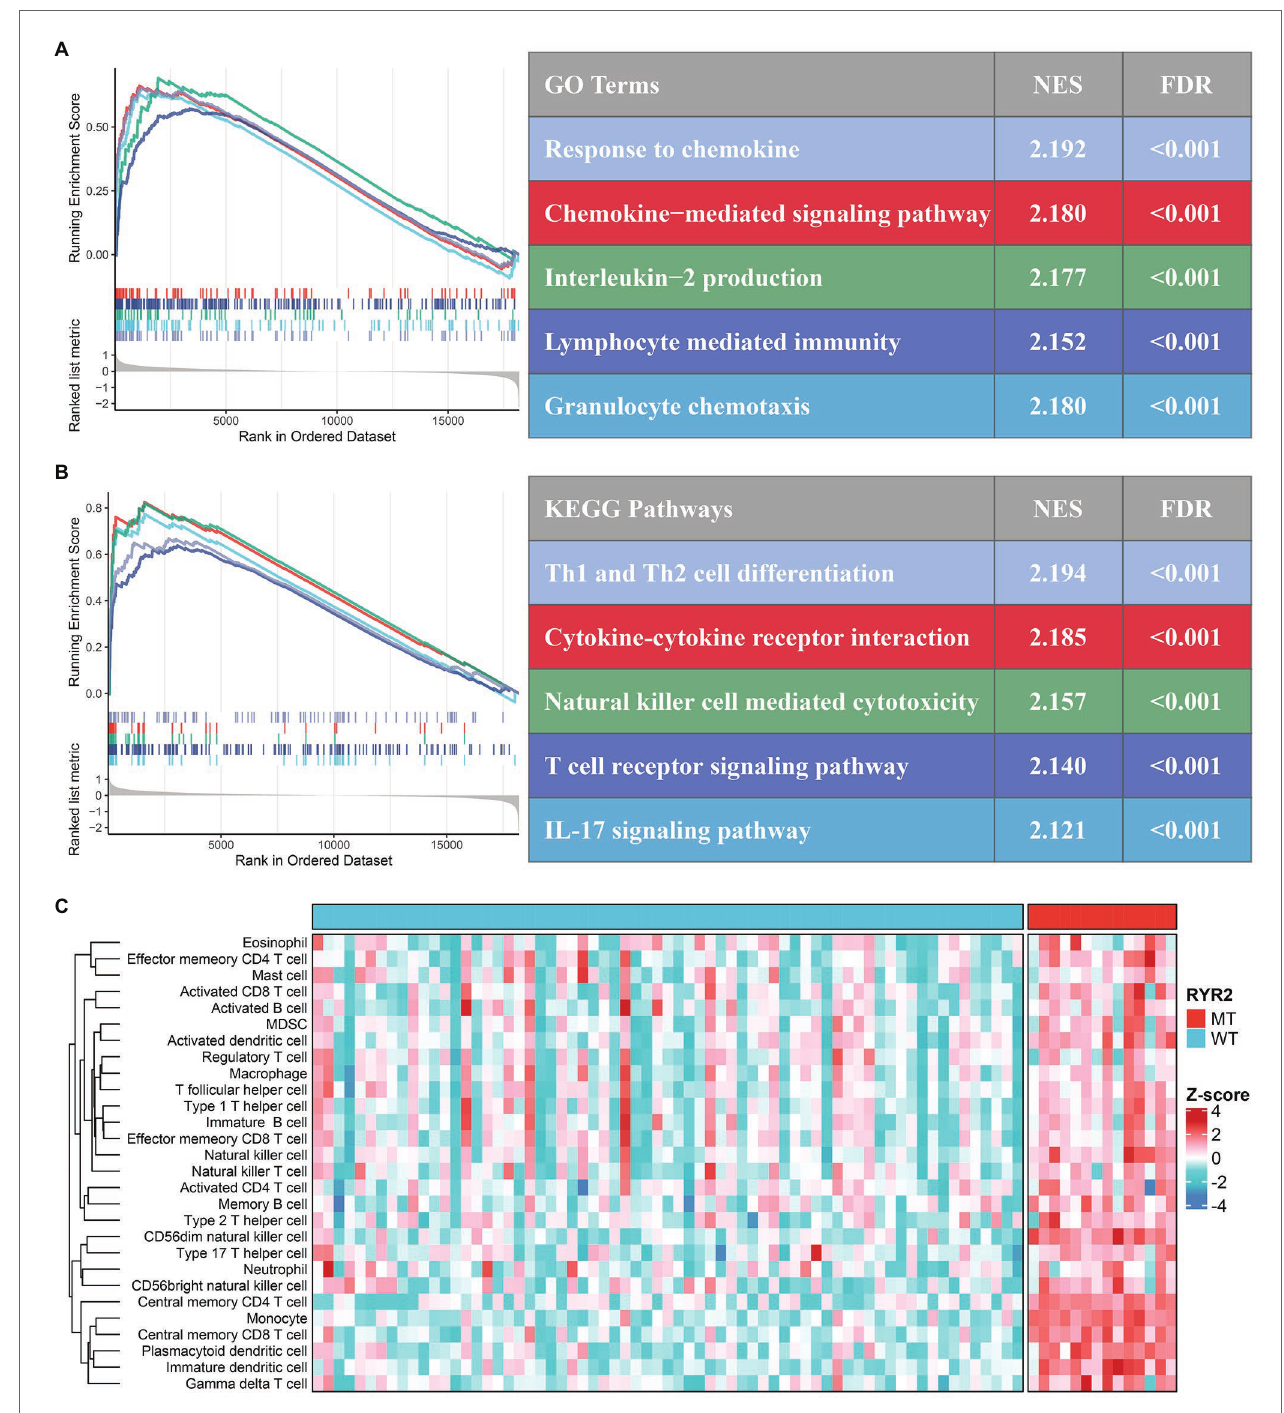
FIGURE 3 | Functional and immune infiltration analysis. (A) Significantly enriched Gene Ontology terms associated with RYR2 mutation. (B) Significantly enriched Kyoto Encyclopedia of Genes and Genomes pathways associated with RYR2 mutation. (C) Assessment of infiltration abundance of 28 immune cells in patients with and without RYR2